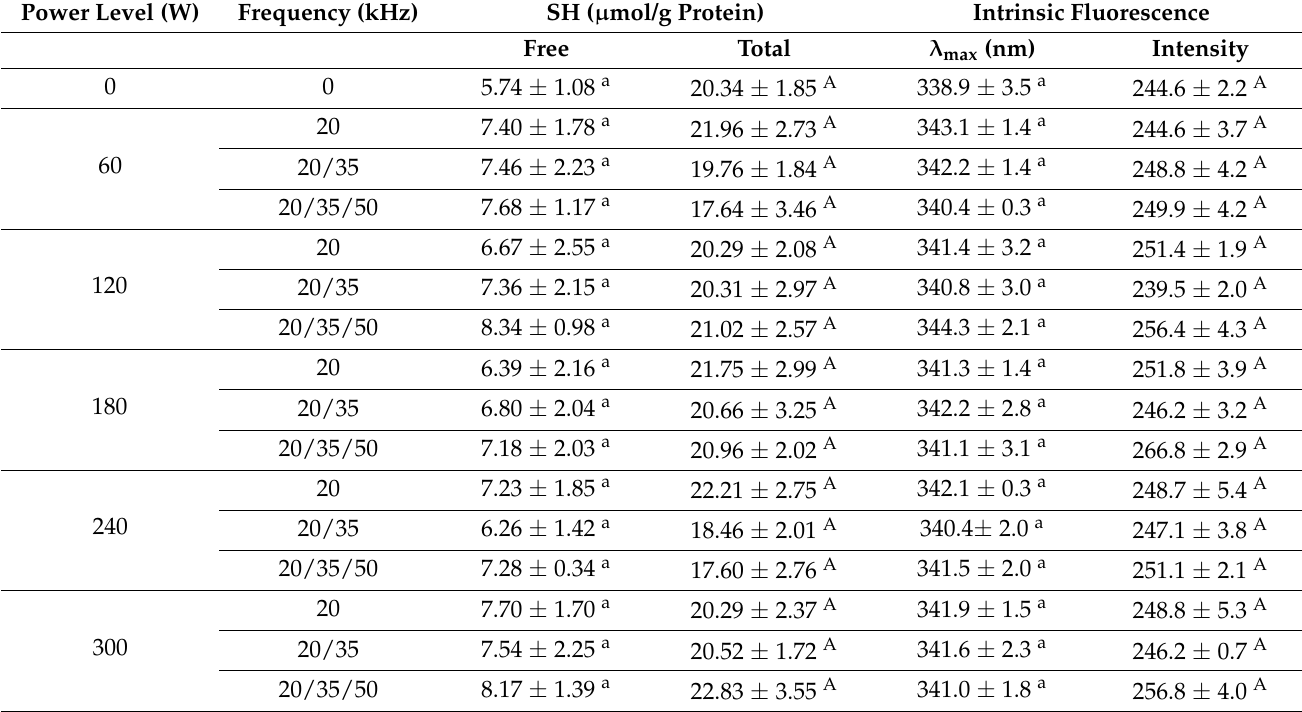
Table 1. Effect of US frequency and power on sulphydryl content and intrinsic fluorescence (n = 3). Power Level